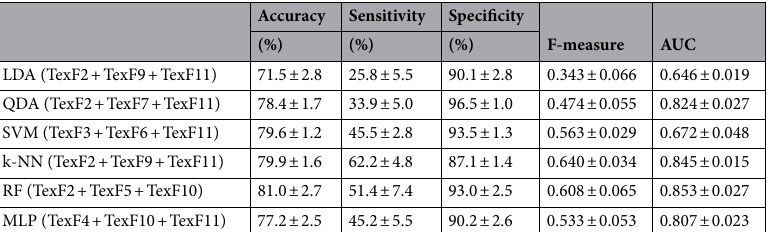
Table 5. Performance of machine learning–based classifications of anti-Jo-1 antibodies. Note Data are means ± standard deviations. Feature name codes are as follows: TexF1 = kurtosis, TexF2 = interquartile range, TexF3 = total energy, TexF4 = cluster prominence, TexF5 = correlation, TexF6 = difference average, TexF7 = imc2, TexF8 = maximum probability, TexF9 = large dependence high gray-level emphasis, TexF10 = dependence non- uniformity, TexF11 = coarseness. LDA linear discriminant analysis, QDA quadratic discriminant analysis, SVM support vector machine, k-NN k-nearest neighbors classifier, RF random forest classifier, MLP multi-layer perceptron.